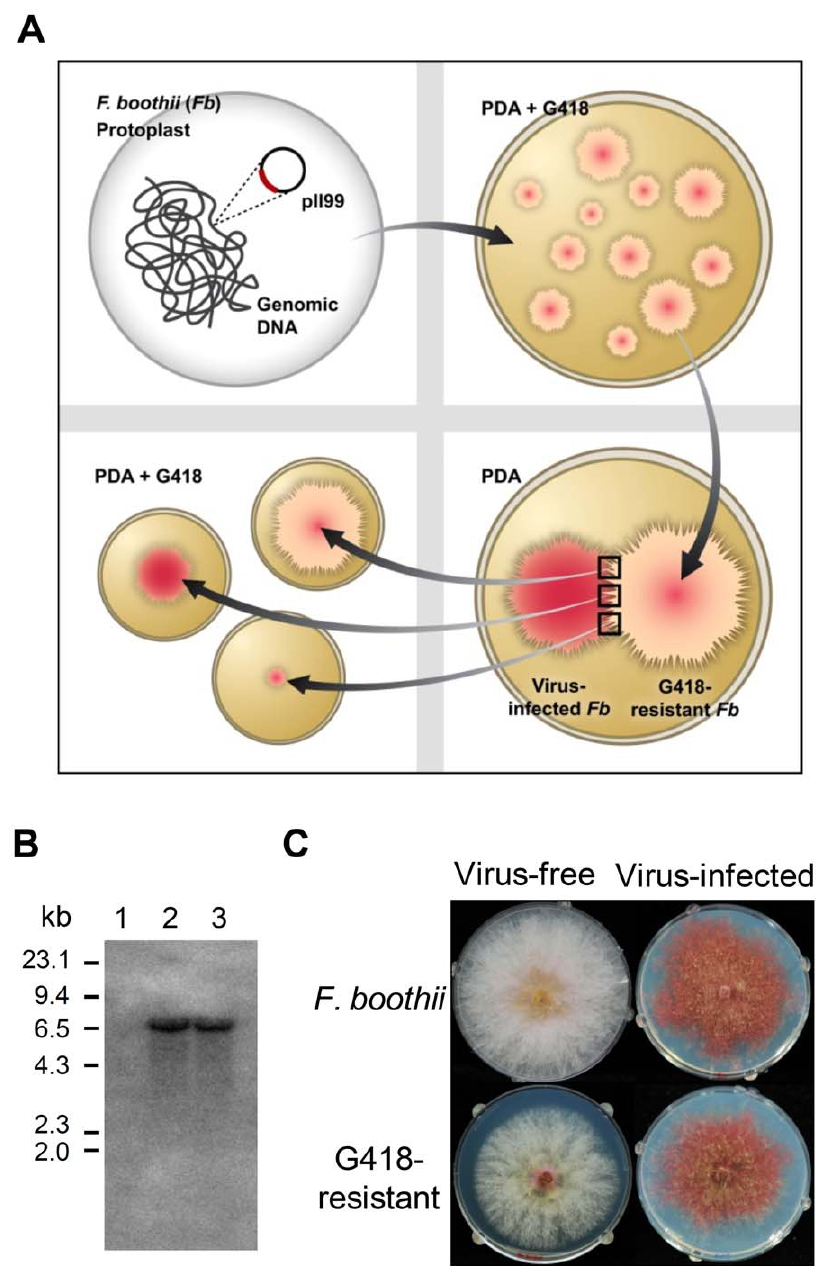
Figure 2. Construction of virus-infected G418-resistant mutant. (A) Strategy of construction of G418-resistant mutant. (B) Southern blotting of Kpn I and Spe I -digested genomic DNAs, hybridized with a 1.9 kb geneticin probe. Lane M, l DNA- Hind III digested DNA marker; lane 1, wild-type; lane 2, G418-resistant strain; lane 3, virus-infected strain (G418-selected). (C) Colony morphology of virus-free and -infected of wild-type and G418- resistant strains 5 days after inoculation.